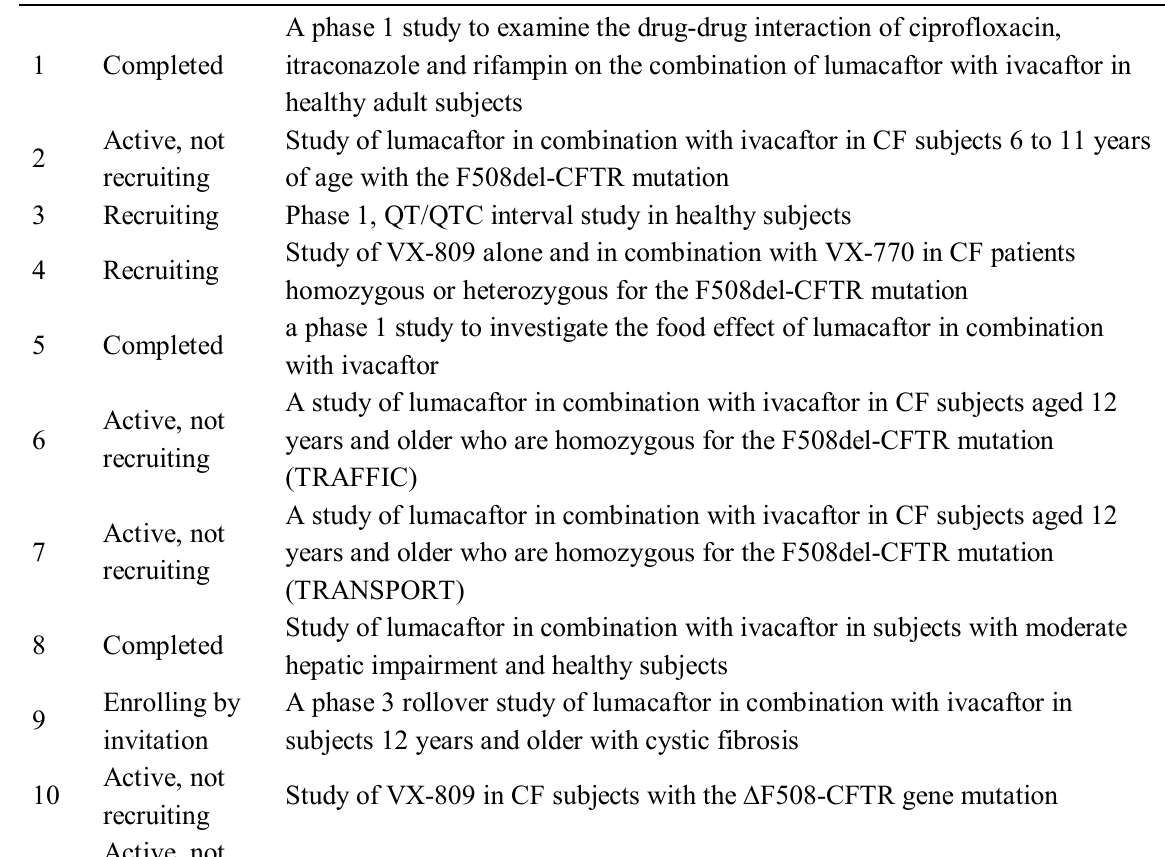
Table 5. Lumacaftor studies on